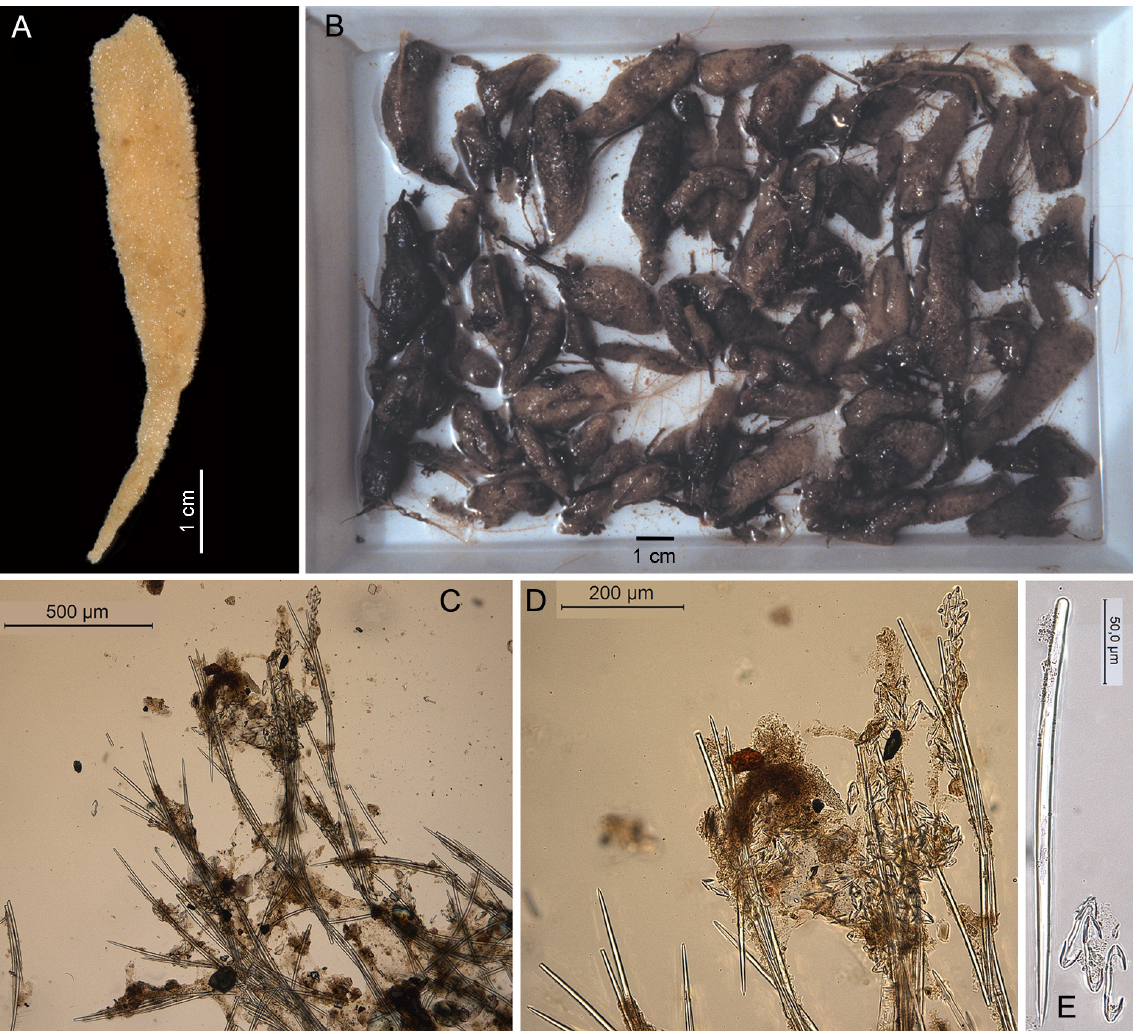
Fig. 2. Amphilectus utriculus sp. nov. A,C-E . Holotype ZMA Por. 22592. B . Paratypes ZMA Por. 06636. C . Cross section showing skeletal structure. D . Peripheral skeleton showing protruding spicule tracts and clusters of microscleres. E . Spicules in light